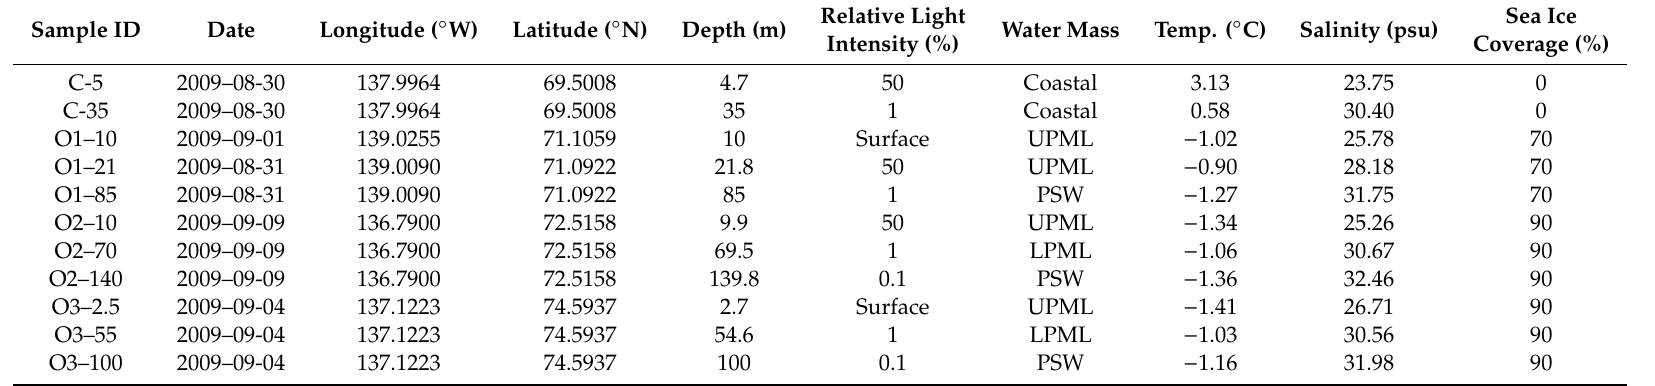
Table 1. Physical and hydrographical parameters for samples in this